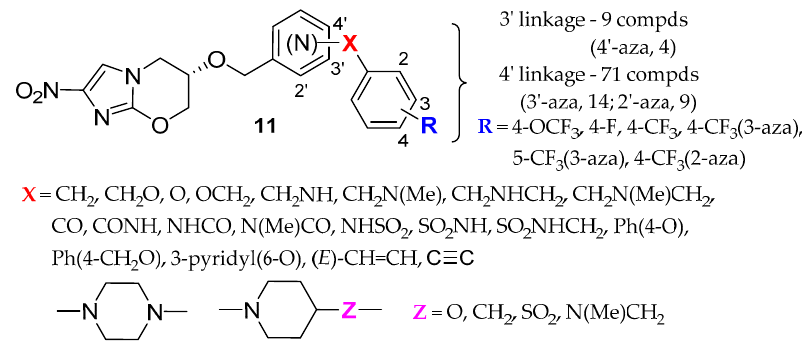
Figure 6. Analogues ( 11 ) of pretomanid with variable linkers (X) between aryl rings.